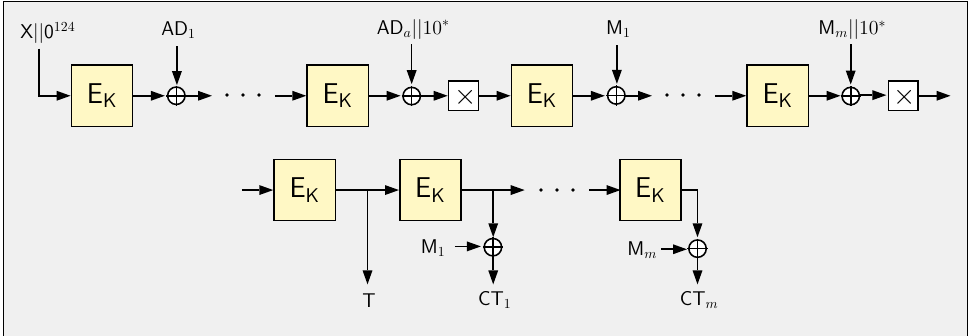
Figure 9: The high-level overview of SUNDAE-GIFT , which depicts the processing of m message and a associated data blocks. X denotes a 4-bit parameter, whose value depends on the length of the nonce and whether there are no AD or message